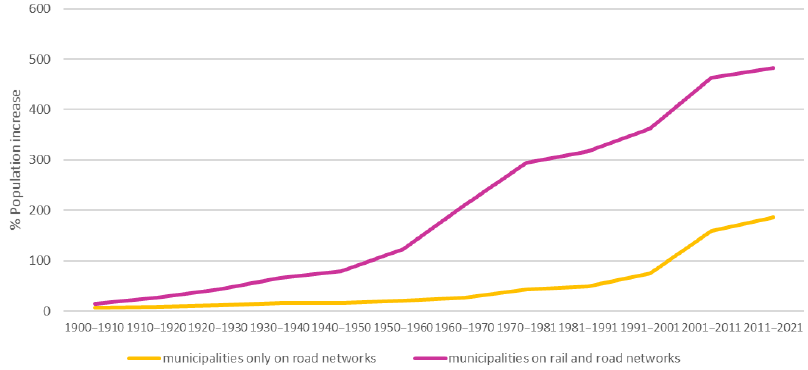
Figure 6. Percentage increases in population compared to 1900.